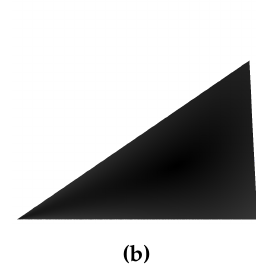
Figure 16. ( a ) Angular distortion mapped to a greyscale value across a face of an icosahedron. ( b ) Angular distortion mapped to a greyscale value across a face of a DT. Black is low distortion and white is high distortion. We have used the same greyscale mapping for both for direct